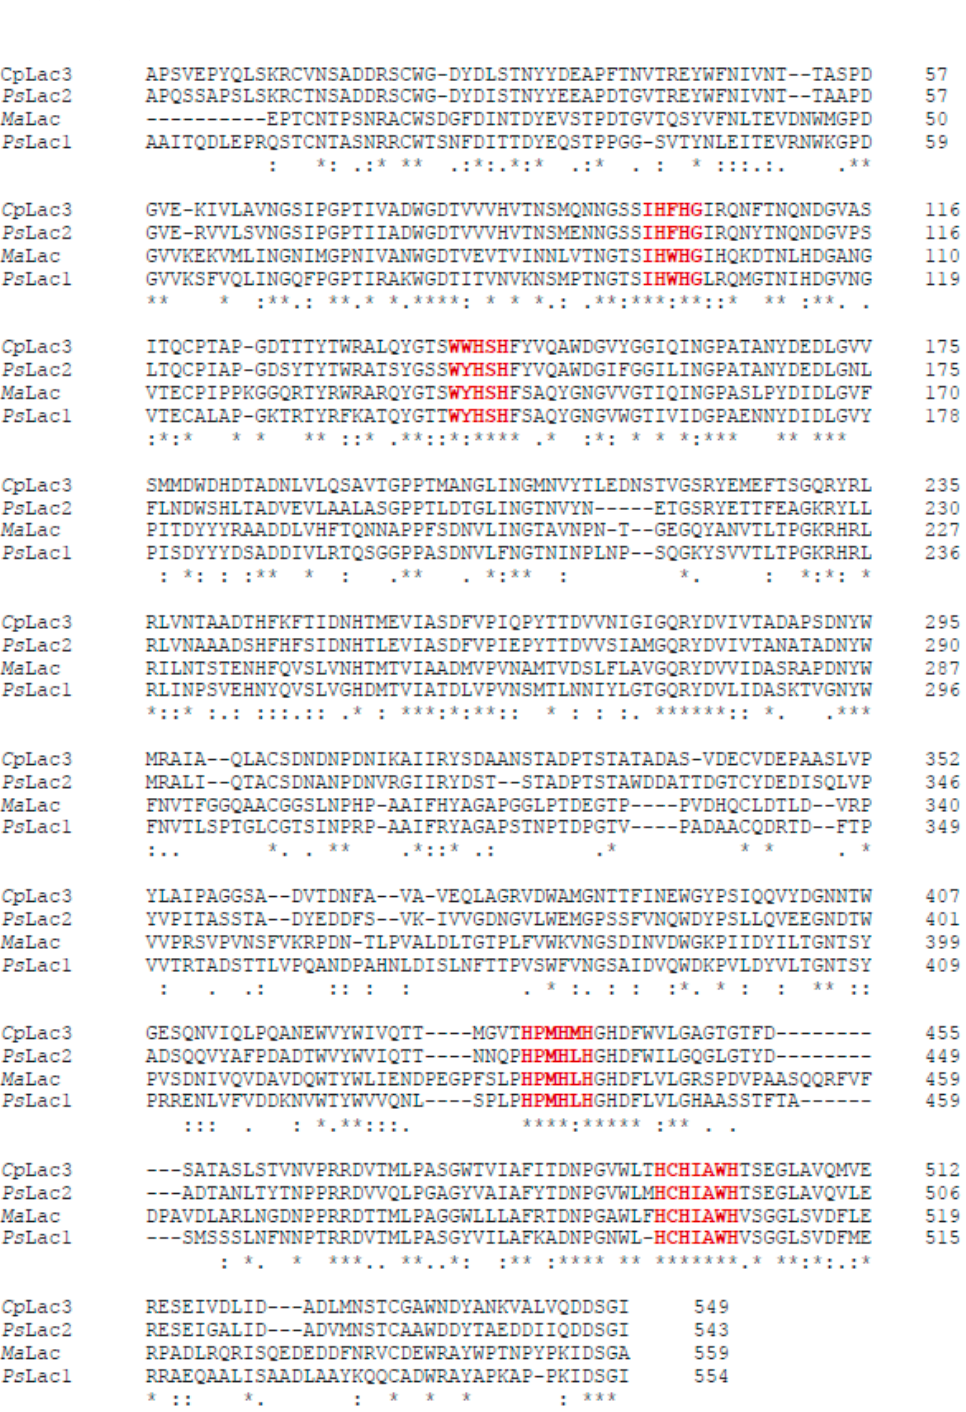
Figure 1. Alignments of the closest characterized laccases from Melanocarpus albomyces ( Ma Lac, 3DKH_A) and Cryphonectria parasitica ( Cp Lac3, AAY99671) to Pestalotopsis sp. Lac1 (KY554800), and Pestalotiopsis sp. Lac2 (KY554801) using the CLUSTAL W sequence alignment algorithm. Perfect matches are represented by an asterisk, high-amino acid similarities are represented by double dots, and low-amino acid similarities are represented by single dots. Gaps (-) were introduced for maximum alignment. The amino acids involved in the coordination sites for the type 1, 2 and 3 coppers are in red and bold.